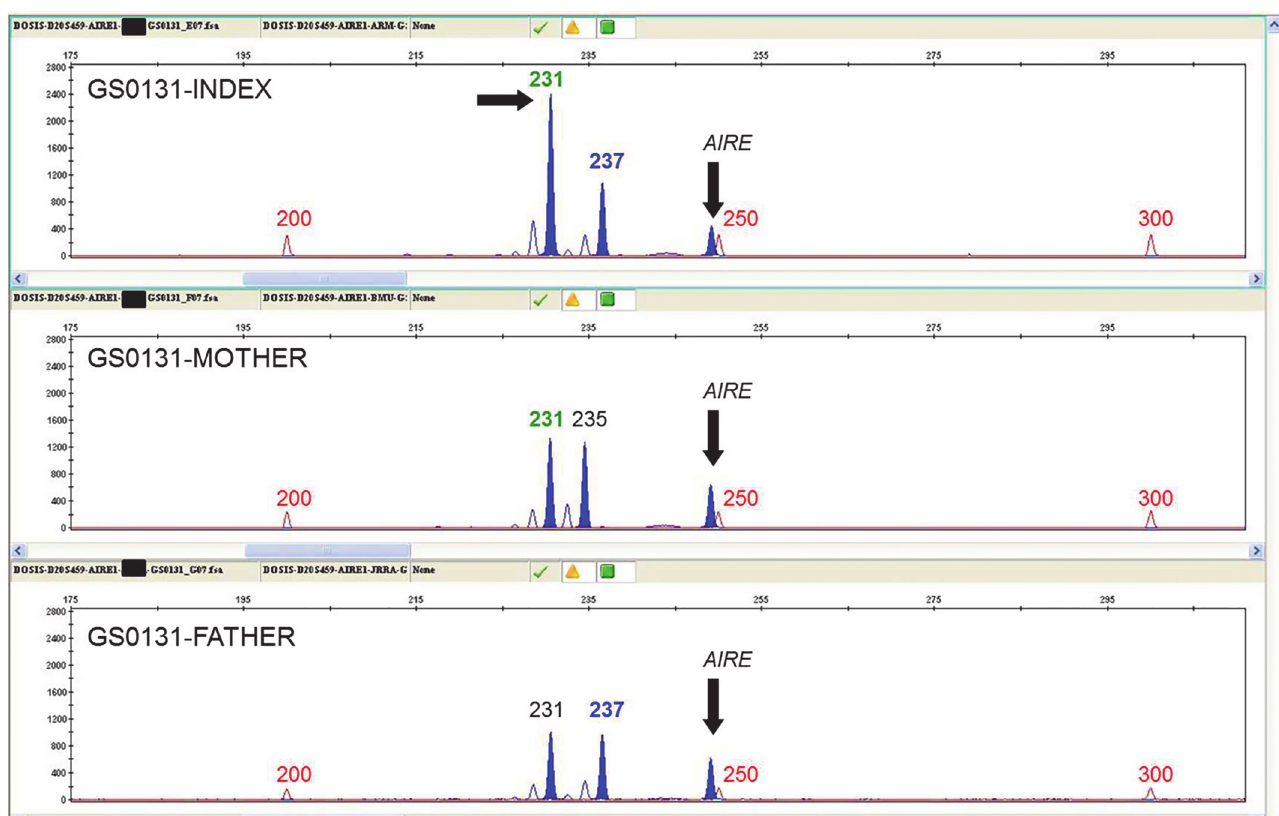
Fig 4. Determination of the parental origin of the duplication in family GS0131. Electropherogram showing the quantitative multiplex PCR of short fluorescent fragments (QMPSF) of microsatellite D20S459 from family GS0131 members against exon 6 of AIRE (21q22), used as a control amplicon. From up to down, results for the index case, mother and father. Vertical arrows show the control fragment. The horizontal arrow indicates the maternally-inherited duplicated allele in the index case. Figures show the size of the fragments in base pairs (red: weight marker; green: maternally-inherited allele; blue: paternally-inherited allele). Similar data were obtained using other control amplicons: exon 2 of HNF1A (12q24) and exon 3 of HNF1B (17q12). Data of these experiments are not